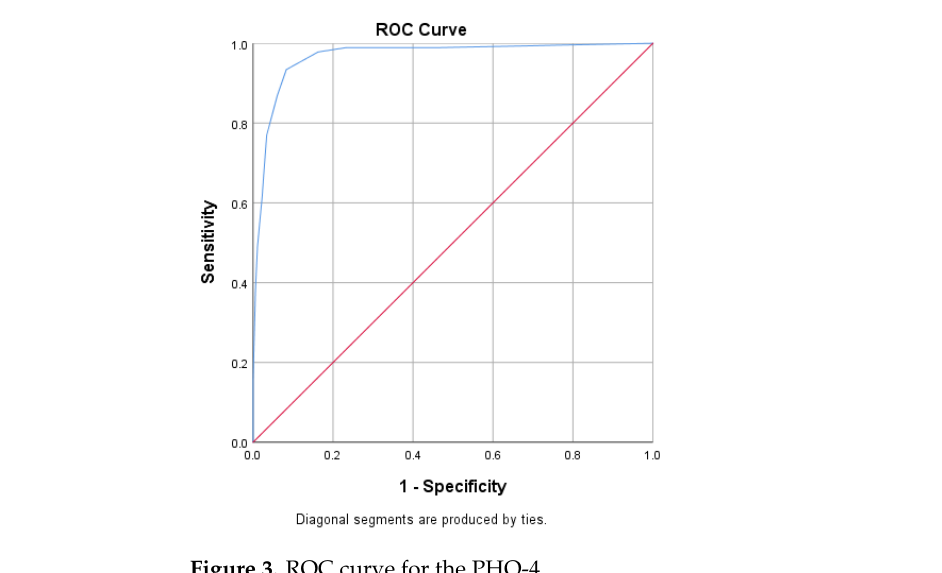
Figure 5. ROC curve for the HAMD-4. Table 2. Fit indices for the HAMD-6 and HAMD-4. Metric for Goodness of Fit